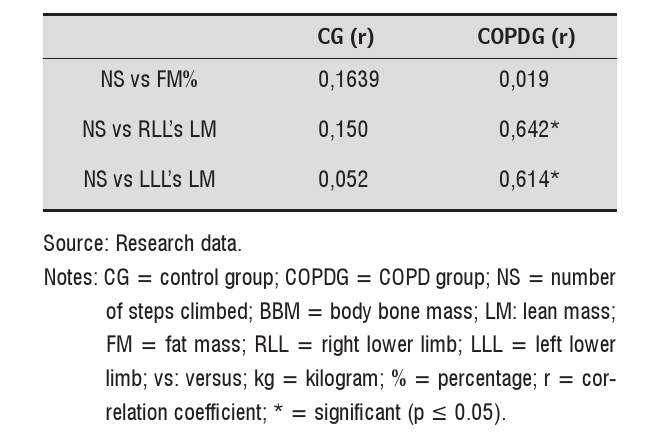
Table 3 - Correlation between 6MST’s NS and body com- position in CG and